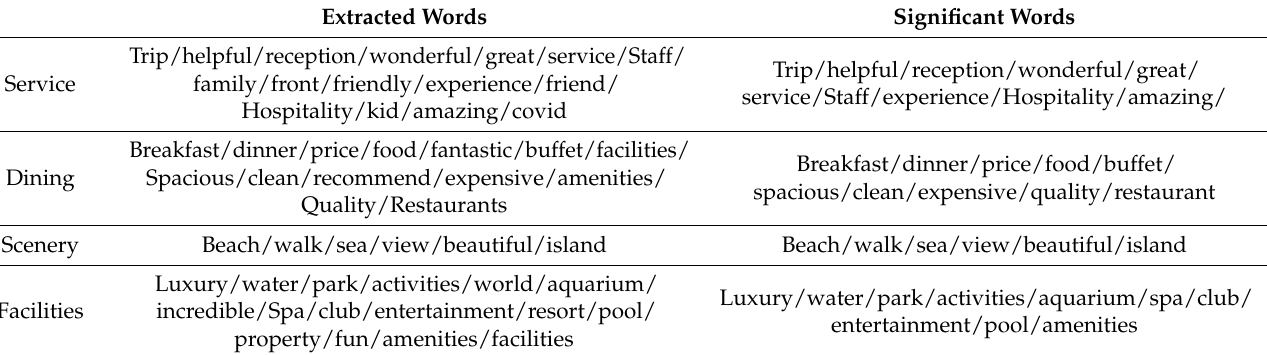
Figure 3. Atlantis, The Palm—visualization with CONCOR analysis. Table 3. Results of CONCOR analysis.